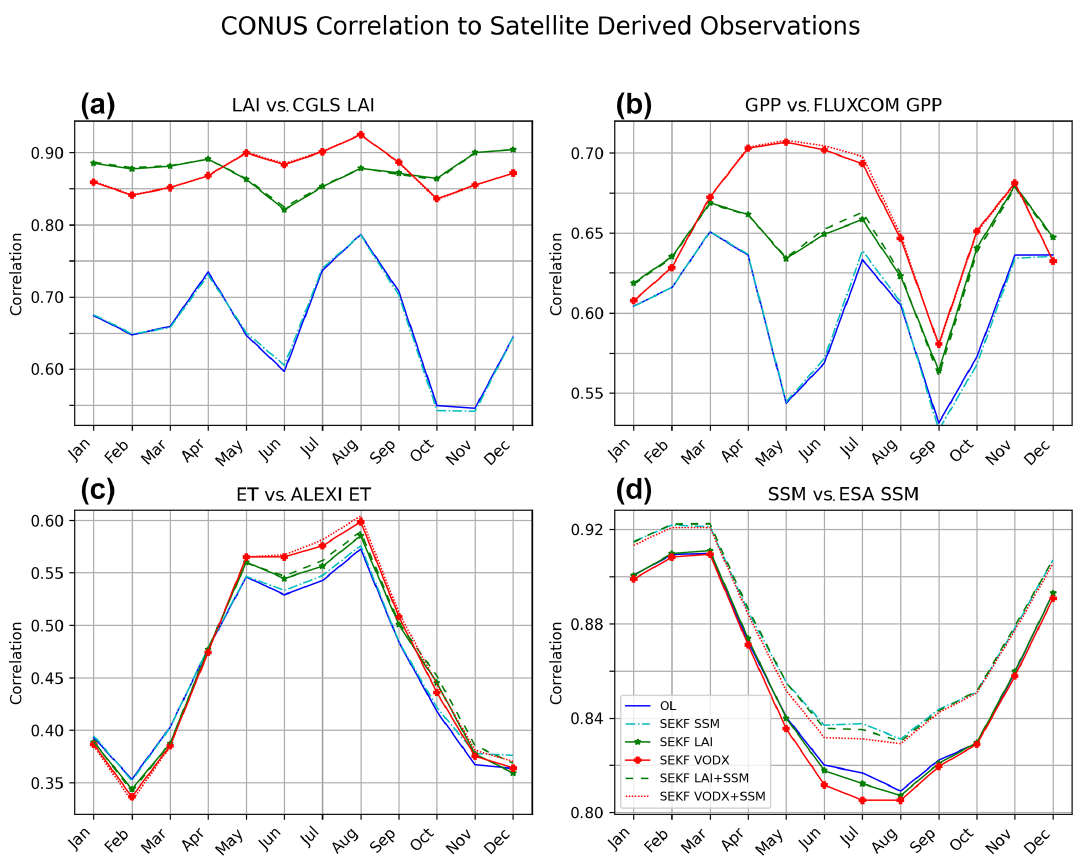
Figure 10. Graphs of monthly correlations over CONUS between the LDAS-Monde OL (solid blue line), SEKF SSM (dash-dotted cyan line), SEKF LAI (solid green line with star markers), SEKF VODX (solid red line with cross markers), SEKF LAI SSM (dashed green line), and SEKF VODX SSM (dotted red line) and satellite-derived observations of (a) LAI (2003 to 2018), (b) GPP (2003 to 2013), (c) ET (2003 to 2018), and (d) SSM (2003 to